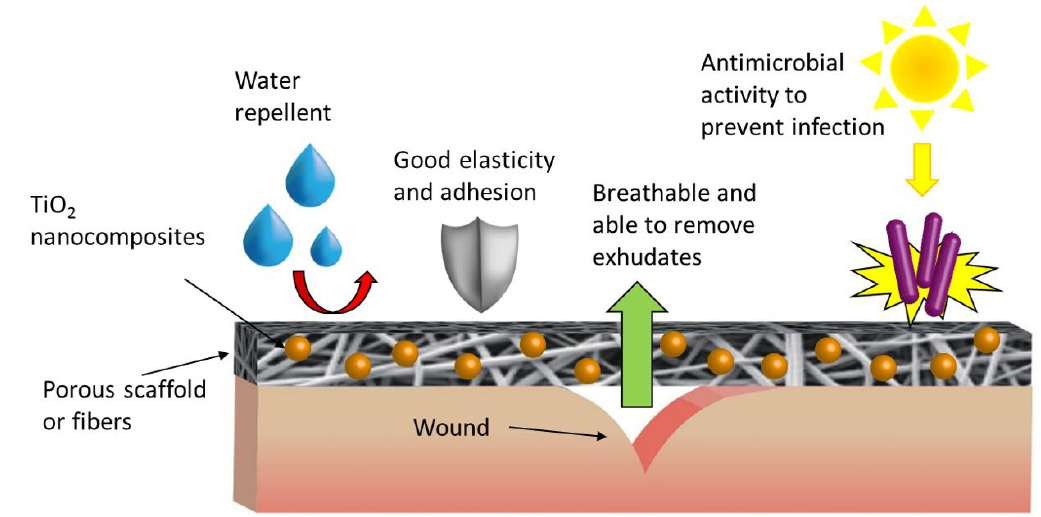
Figure 11. General scheme of TiO 2 NPs-based nanocomposite application for biomaterial-related applications highlighting the ability to repel water, to adhere to the skin following its movements, to remove exudates, to be permeable to air, and to prevent infections due to the antimicrobial activity driven by photocatalysis.